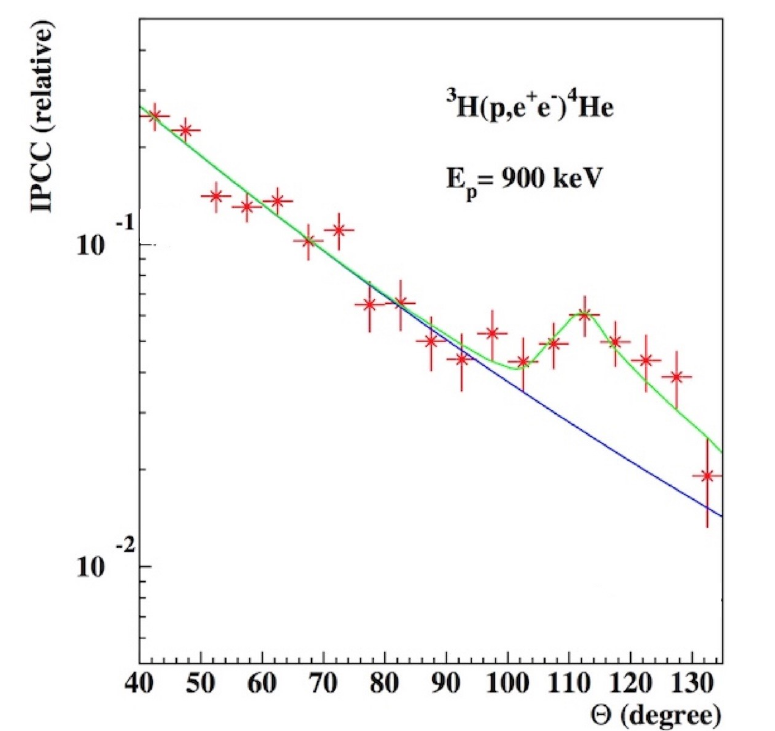
Figure 1. Angular correlations for the e - e + pairs measured in the 3 H(p,e - e + ) 4 He reaction at E p = 900 keV. The red points are the experimental data showing the e - e + pairs excess around 115 ◦ . The blue is the expected angular distribution of e - e + pairs based on standard IPC physics, while the green line is the best data fit assuming M X 17 = 16.87